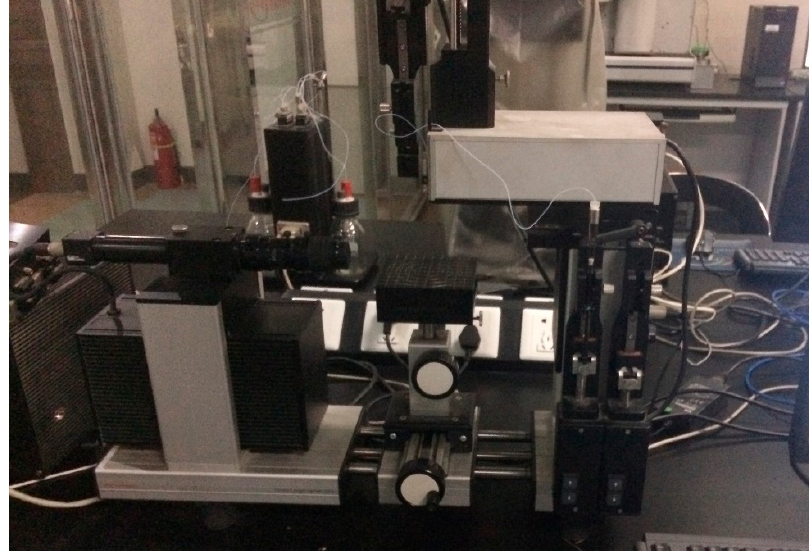
Figure 10. Optical video contact angle tester (OCA20).